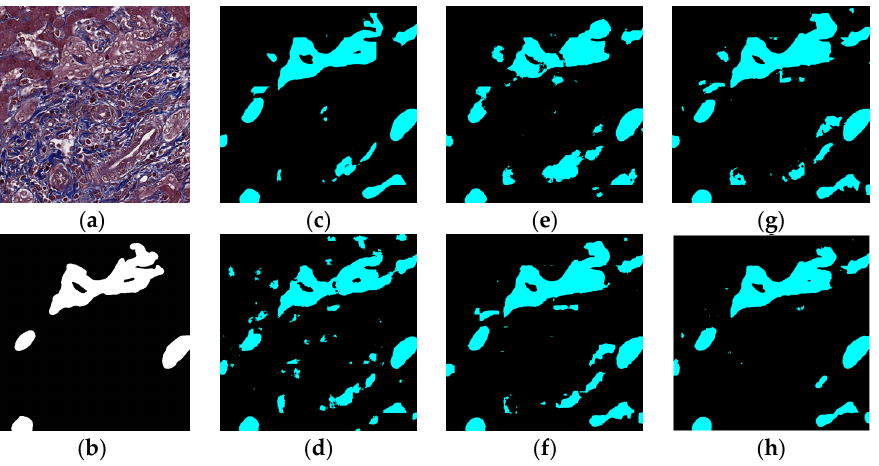
Figure 10. Segmentation results for the case in which cells in arteries are much similar to real bile ducts: original ( a ), GT ( b ), FCN ( c ), SegNet ( d ), U ‐ Net ( e ), Deeplabv3 ( f ), Deeplabv3 ‐ plus ( g ), and the proposed network ( h ).